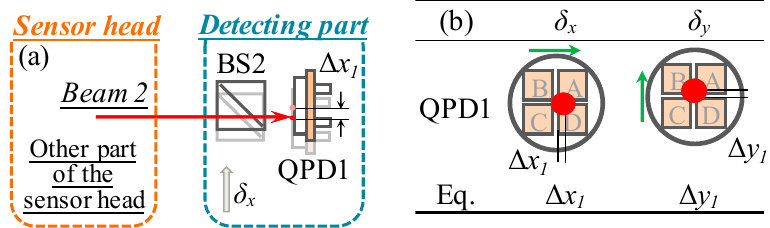
Figure 2. Measurement principle of the straightness errors: ( a ) Optical layout of straightness errors measurement kit, ( b ) variations of laser beam positions on quadrant-photodetectors (QPDs).